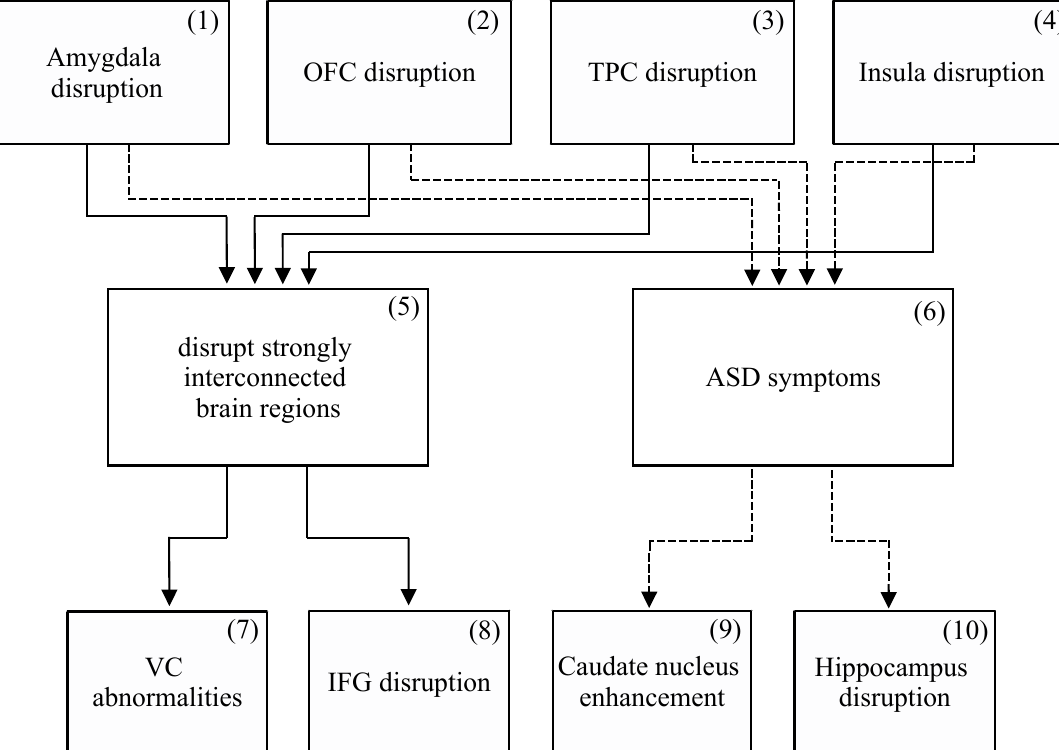
Figure 1. Summary of disrupted neurocircuitry. Four social brain regions are commonly disrupted and these disruptions and the resulting symptoms drive additional abnormalities of the visual cortex, inferior frontal gyrus, caudate nucleus, and hippocampus. ASD, autism spectrum disorders; IFG, inferior frontal gyrus; OFC, orbitofrontal cortex; TPC, temporoparietal cortex; VC, visual